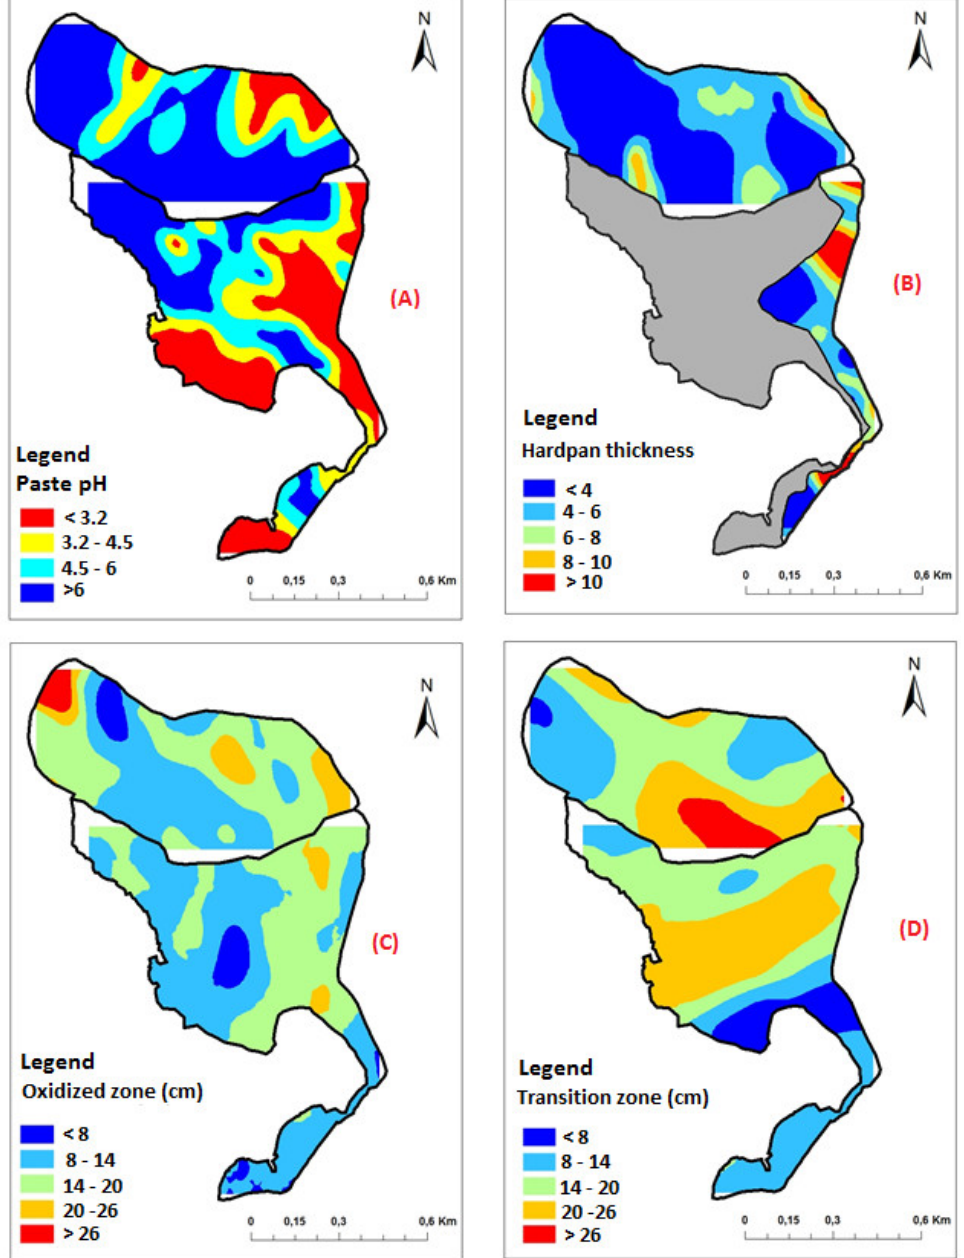
Figure 8. Mapping of: ( A ) paste pH, ( B ) hardpan thickness, ( C ) oxidized zone, and ( D ) transition zone.